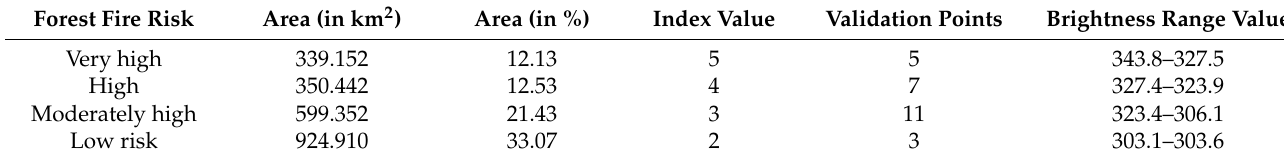
Table 5. Forest fire risk area distribution with validation points.